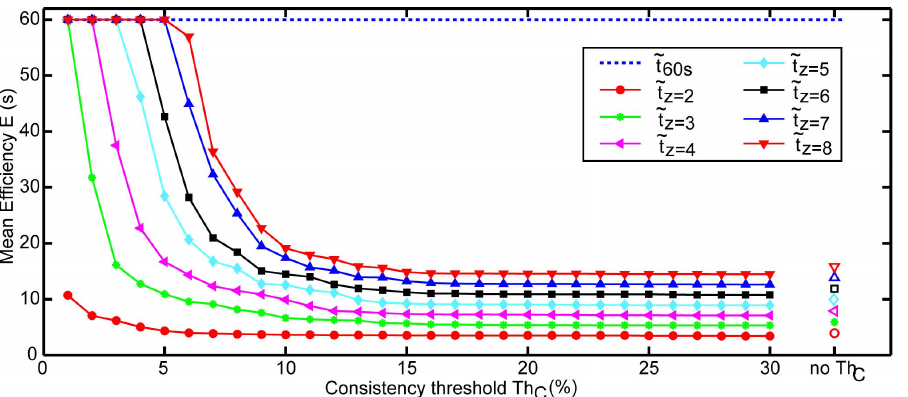
Figure 6. Plot of mean efficiency (cid:2) EE for measurement against consistency threshold Th C for the different number of time intervals in a set (z). (cid:2) EE became greater with tighter Th C and with increasing z.